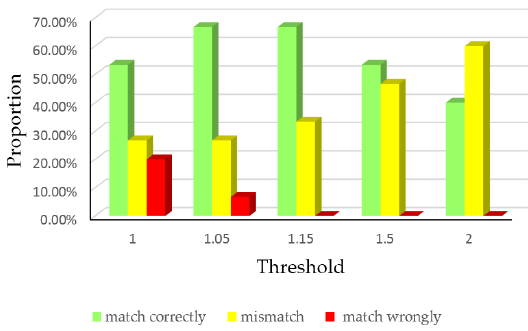
Figure 11. The matching results of different thresholds with the limitation of two contexts.